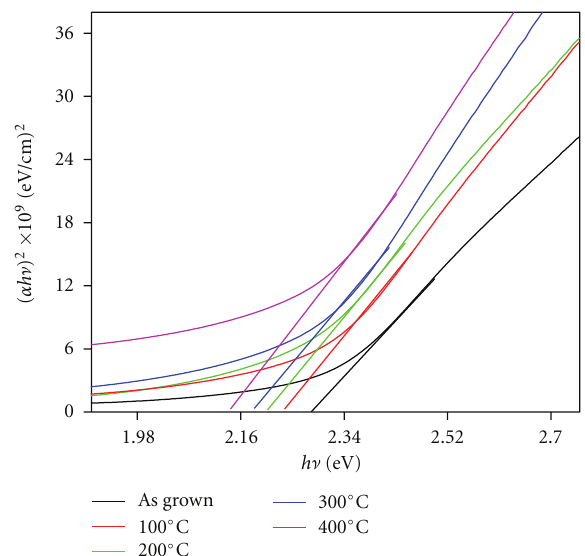
Figure 6: The energy band gap plot between ( αh ν ) 2 verses h ν (eV) for as grown and annealed, Ag-doped nanostructured CdS thin